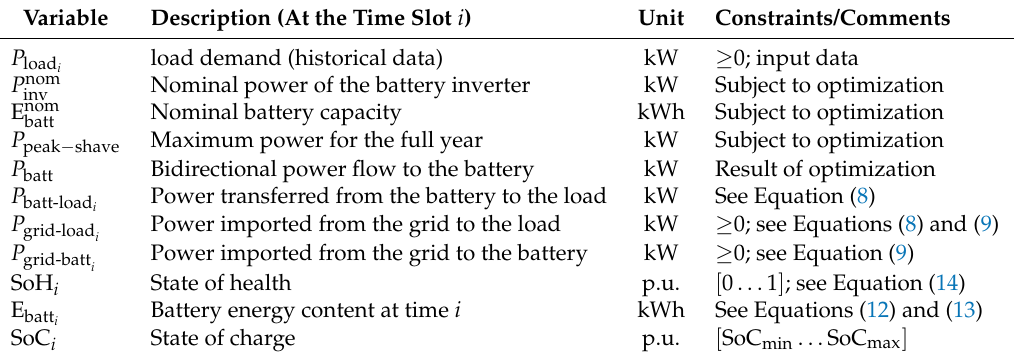
Table 2. Variables and parameters used for the battery modeling and optimization